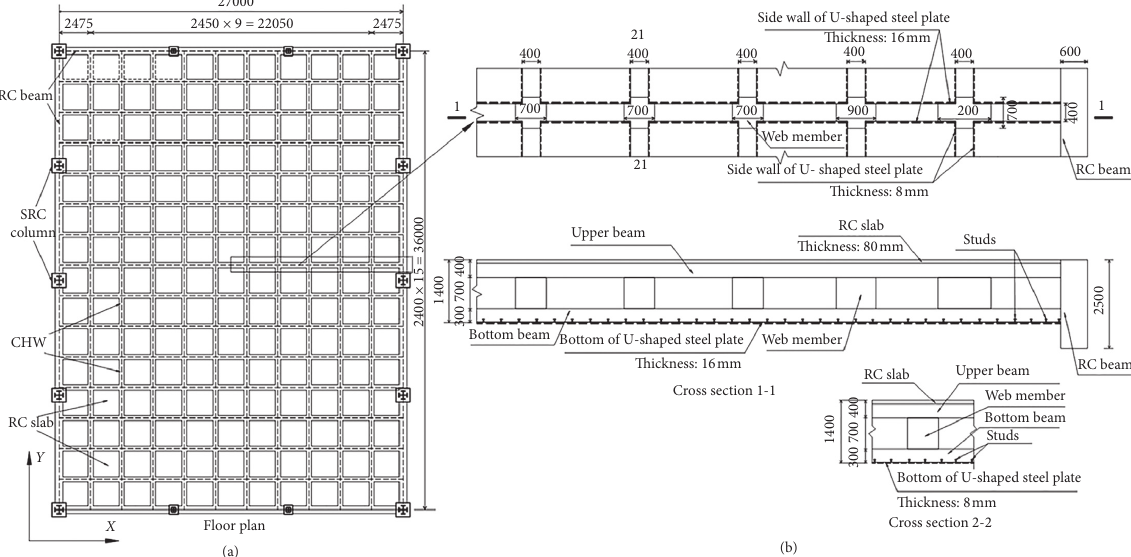
Figure 3: The CHW slab: (a) overview structural layout of the floor; (b) detailed layout of the